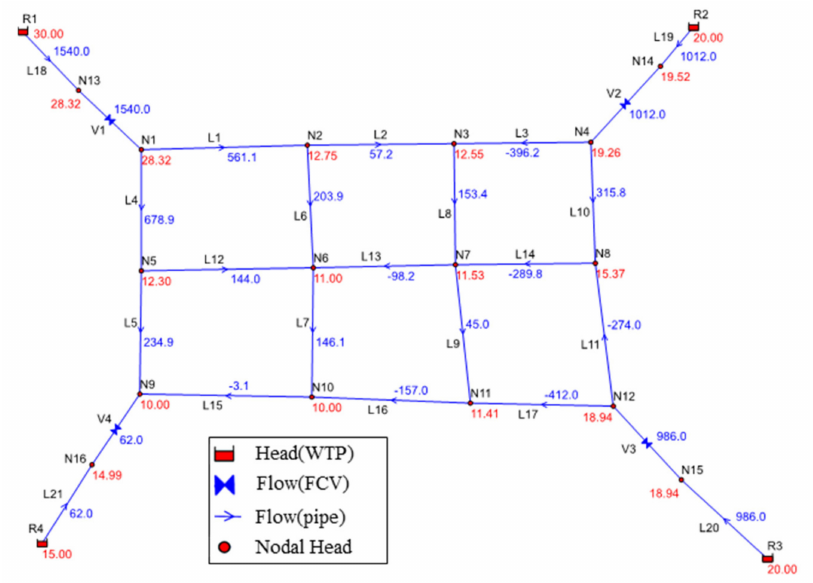
Figure 7. Hydraulic analysis results of the network by the